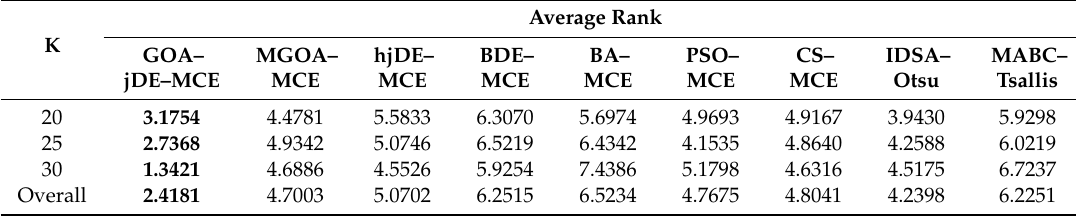
Table 12. Average rank of the results for each algorithm on the SIPI Image